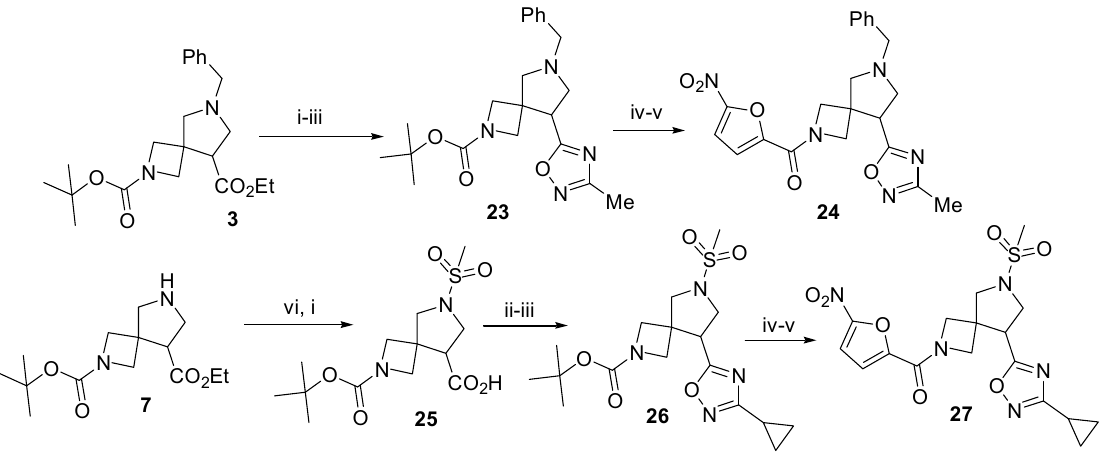
Scheme 5. Synthesis of 1,2,4-oxadiazole derivatives. Reagents and conditions: i. LiOH · H 2 O, aq. 1,4- dioxane, r. t., 12 h; ii. acetamidoxime, HOBt, EDC · HCl, r. t., 12 h; iii. TBAF, toluene, Dean-Stark trap, reflux, 6 h ( 23 41%, 26 63%, 3 steps); iv. TFA, CH 2 Cl 2 , 0 °C → r. t., 1 h; v. 5-nitro-2-furoic acid, CDI,